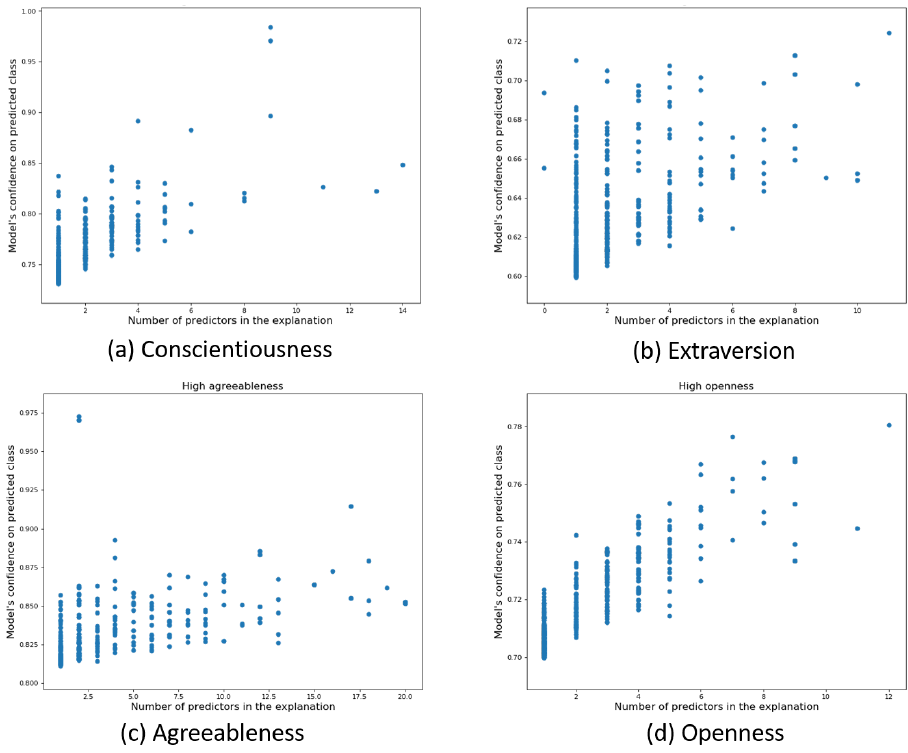
Figure A5. Model’s predicted scores vs. number of features in the explanation to counterfactually explain the predicted class. The correlations between the confidence scores and explanation sizes are 0.72 (Conscientiousness), 0.52 (Extraversion), 0.44 (Agreeableness), 0.87